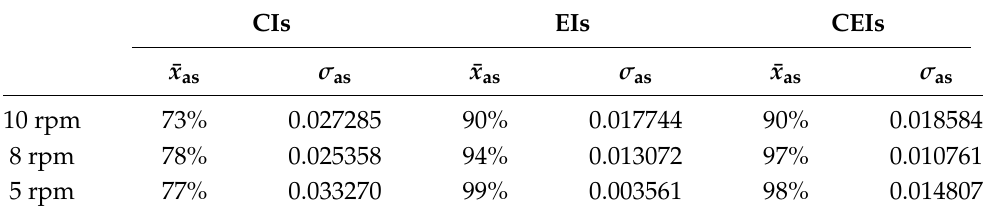
Table 2. Average ¯ x as and standard deviation σ as of the accuracy classification score from 1000 trained models of random forest classifier by the use of classic indicators (CIs), entropy indicators (EIs), and classic and entropy indicator (CEIs) for signals at 5, 8, and 10